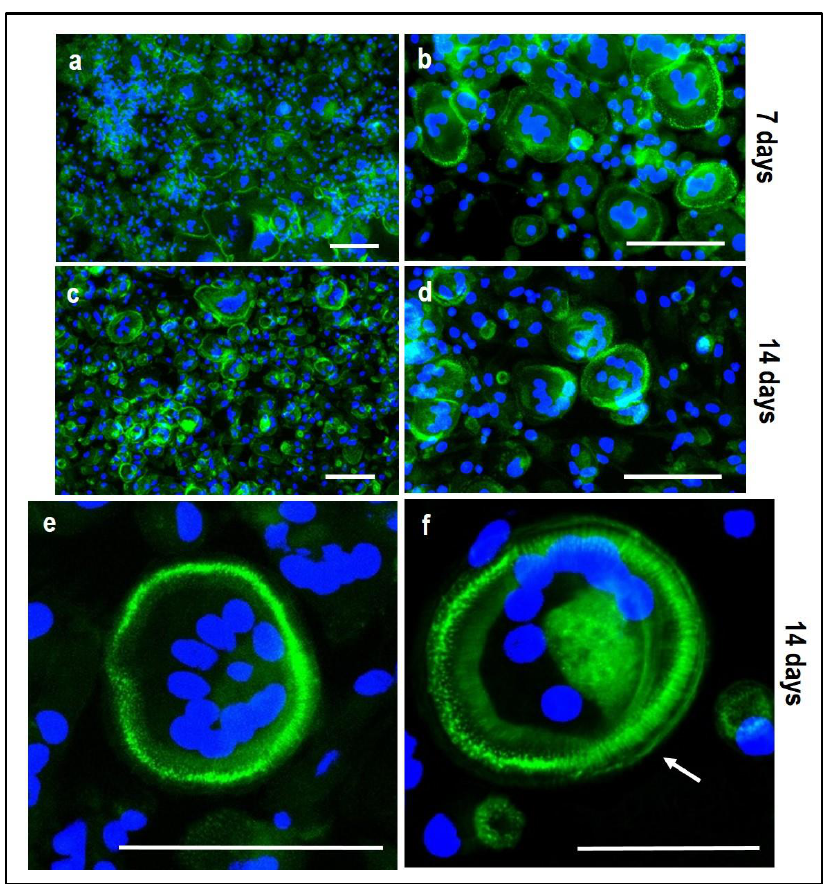
Figure 11. Microphotographs of PBMCs derived from the single-culture induced with M-CSF and RANKL, stained for multinuclearity (Hoechst dye, blue) and actin filaments/ring (Phalloidin-FITC, green) at 7 and 14 days. ( a , b ): single-culture (control culture) at 7 days, ( c , d ): single-culture at 14 days, ( e , f ): details of single-culture at 14 days. Scale bar: 100 µm. In addition, TRAP-positive multinucleated giant cells in the osteogenic medium and basal medium were manually counted and compared to the control (Figure 12). The analysis was performed by light microscopy on ten fields at 20× magnification.